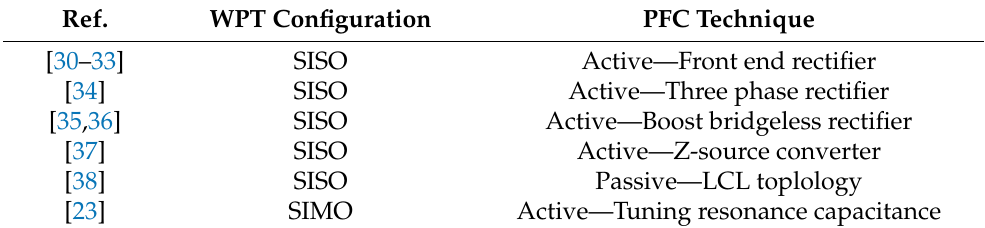
Table 3. Existing WPT studies in terms of power factor